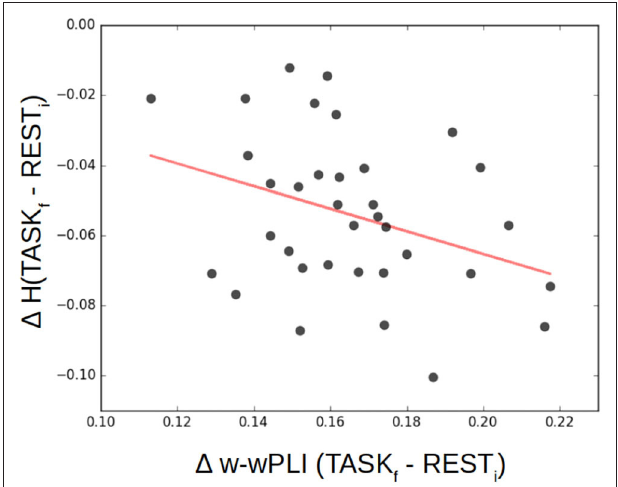
-H REST as a f i − W-wPLI REST , averaged across the f i